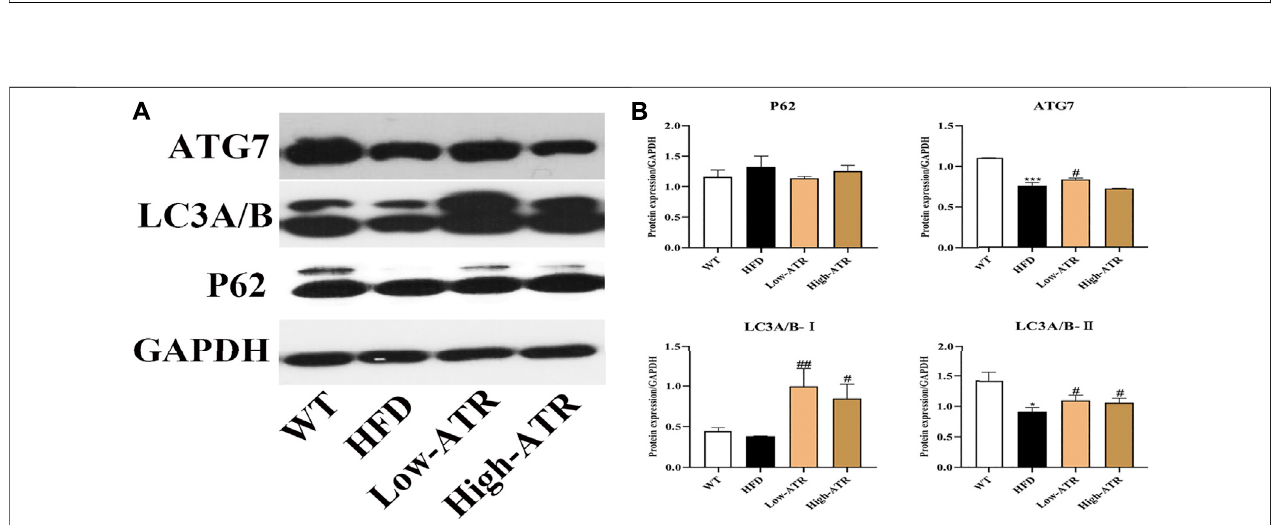
FIGURE 4 | The autophagy induced by ATR in HFD mice. (A) Immunoblot analysis results of P62, LC3A/B, and ATG7. (B) The relative protein expression in reference to GAPDH. Data are expressed as mean ± SD ( n (cid:2) 8). * p < 0.05, ** p < 0.01, *** p < 0.001 (* represents HFD groups compared with the WT group). # p < 0.05, ## p < 0.01, ### p < 0.001 ( # represents ATR treatments compared with the HFD group). WT (cid:2) control group and HFD (cid:2) high-fat diet